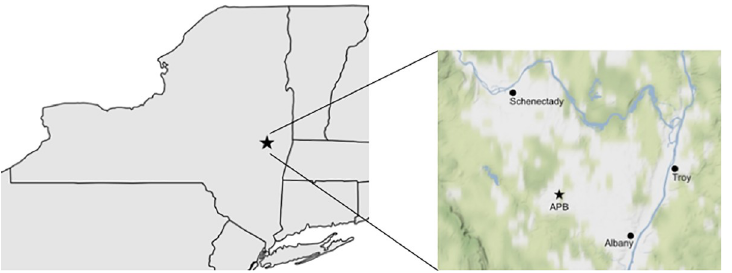
Fig 1. Study area at Albany Pine Bush Preserve in New York State, indicated by the